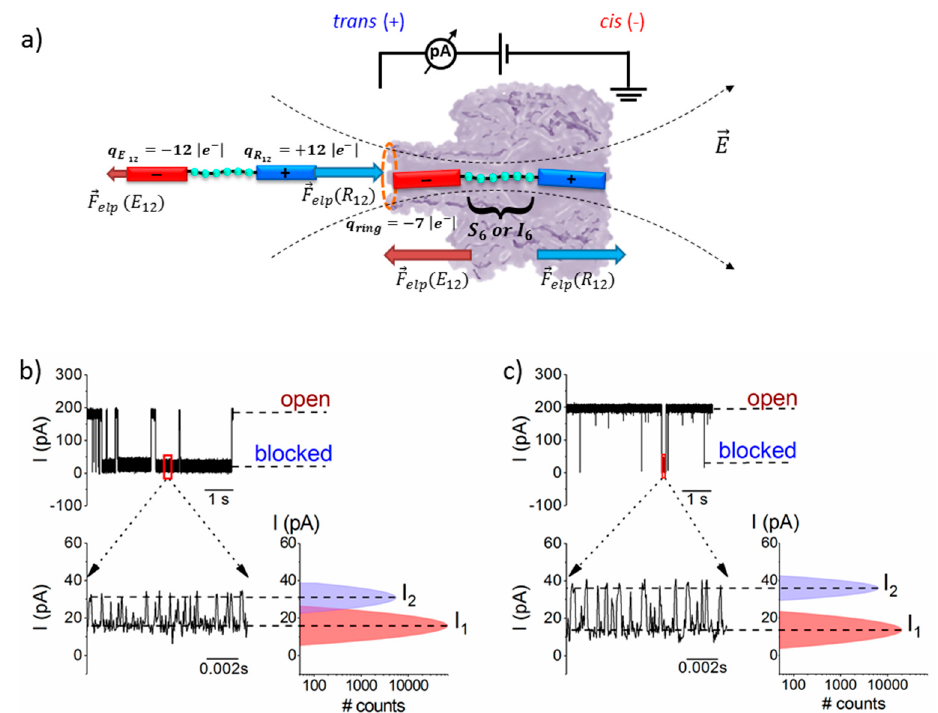
Figure 1. Schematic representation of the model resembling peptide interaction with the α -HL nanopore. ( a ) The R 12 (bare charge ~+12|e − |) and E 12 (bare charge ~ − 12|e − |) tails on the peptides, flanking a middle section containing either S 6 or I 6 amino acids are shown distinctly. As the peptide approaches the nanopore from the bulk, it experiences a stronger electric field ( 𝐸(cid:4652)⃗ ) near the nanopore’s opening [41], which results in uneven electrophoretic forces ( 𝐹⃗ elp ) acting at the peptide’s oppositely charged extremities (at the shown + Δ V , the force acting on the R 12 tail, 𝐹⃗ elp (R 12 ), is larger than the force acting on the E 12 tail, 𝐹⃗ elp (E 12 ), thus driving peptide association to the nanopore). Once the peptide gets captured inside the nanopore, it assumes a meta-stable state, characterized to a first approximation (e.g., constant electric field across the nanopore from the applied Δ V ) and at quasi-equilibrium conditions, by 𝐹⃗ elp (R 12 ) ≈ 𝐹⃗ elp (E 12 ). At neutral pH, the α -HL’s β -barrel entry is negatively charged ( q ring ~ − 7|e − |). The selected original ionic current recordings illustrate the reversible blockades induced by the interactions of 20 μ M trans -added S 6 -(Pe6) ( b ) and I 6 -containing peptide (Pe4) ( c ) with the α -HL, at Δ V = +100 mV. The representative zoomed-in segments below ( b , c ) show the ionic current fluctuations through the α -HL during a metastable capture of the corresponding peptides, and the corresponding ionic current amplitude histograms (see text).